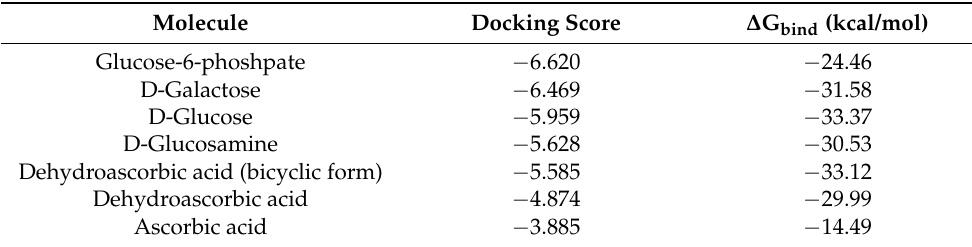
Table 1. Summary of the structural and energy parameters obtained from the protein-ligand docking predictions between GLUT1, hexoses, and DHA-related molecules.